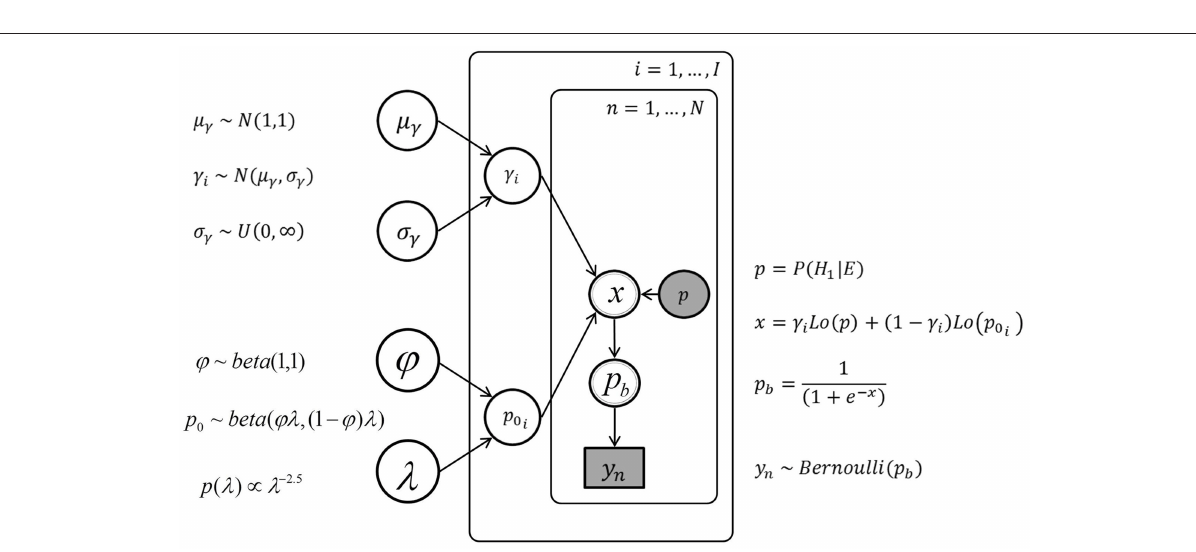
FIGURE 6 | The graph of the hierarchical Bayesian network, with the urn inference y n , the posterior probability p , the individual parameters p 0 i and γ i , and the hyper-parameters µ γ , σ γ and ϕ , λ .